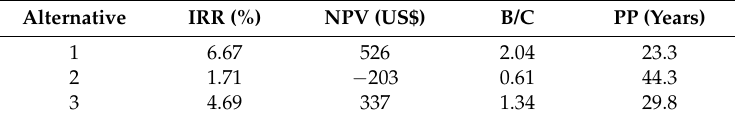
Table 6. Results from the financial assessment of the proposed alternatives.